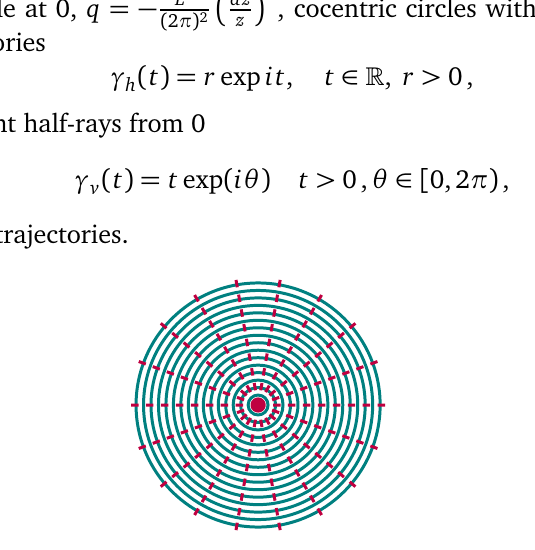
Figure A.11: Horizontal (solid line) and vertical (dashed) trajectories near a double (cid:0) dz (cid:1) 2 2 pole: q = − L ( 2 π ) 2 z